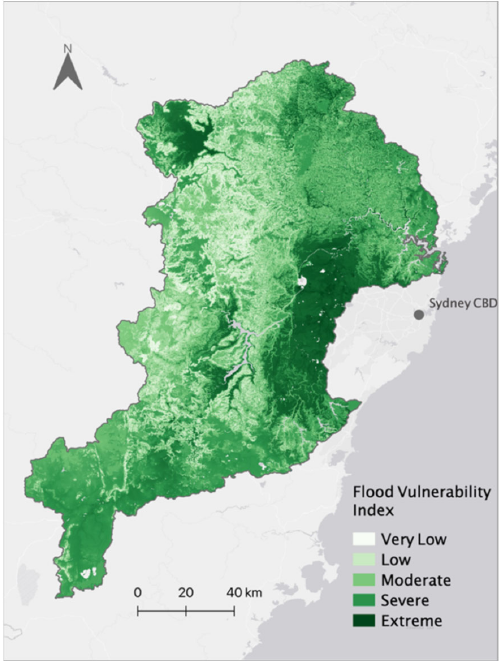
Figure 12. Final Flood Vulnerability Index as a combination of four indicators (Elevation, Slope, IRSD and Hydrologic Soil Groups). This depicts the overall flood vulnerability in the Hawkesbury ‐ Nepean catchment, with darker colours indicating higher vulnerability, and lighter colours indicating less vulnerability.